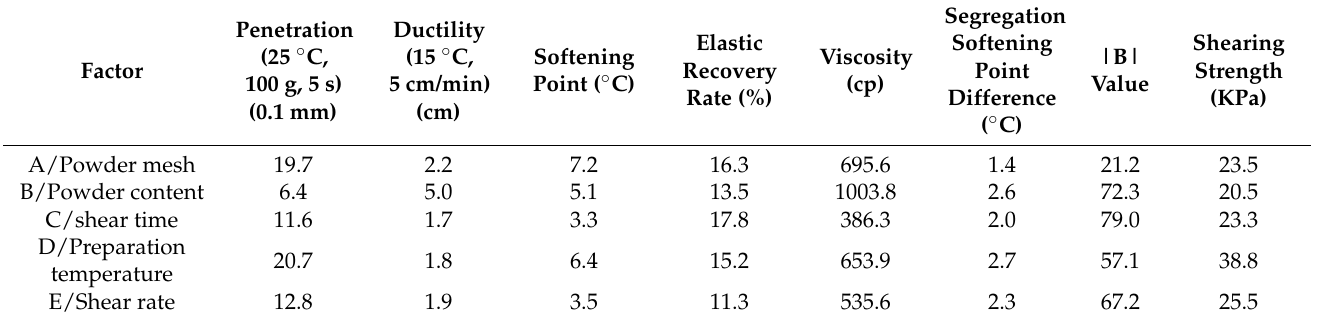
Table 9. Range values of corresponding indexes under various experimental